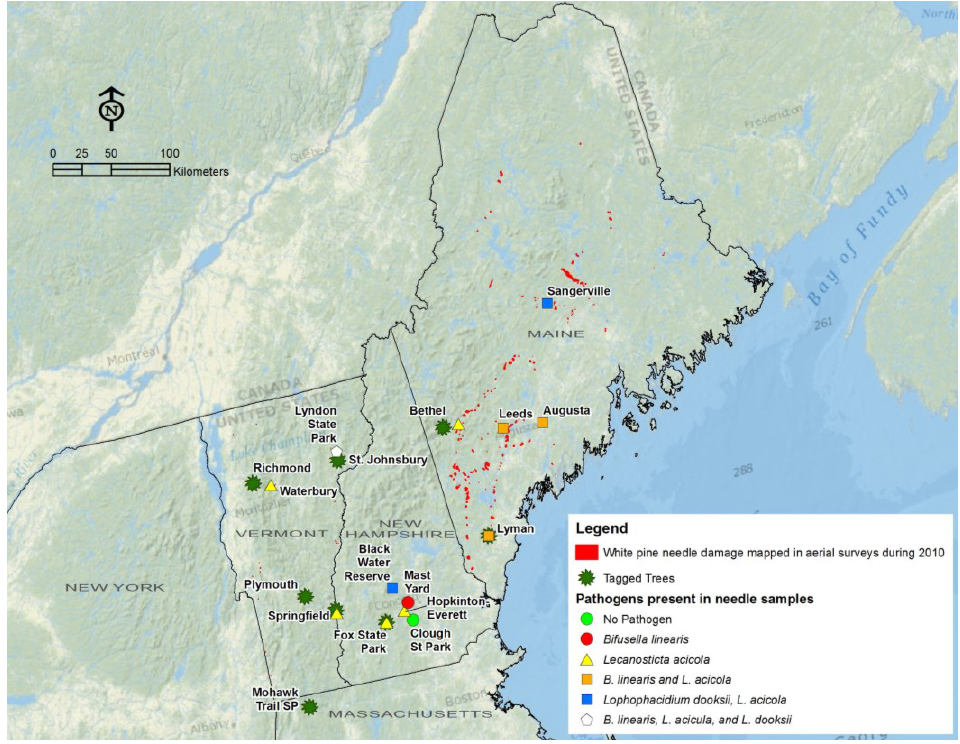
Figure 1. Map of white pine foliar damage detected during aerial detection surveys ( red ), long-term monitoring sites to evaluate repeated defoliation ( dark green ), and 13 sites sampled by State Forest Health Cooperators from Maine, New Hampshire, and Vermont during 2011 and the presence of Bifusella linearis , Lophophacidium dooksii , and Lecanosticta acicola at each of those